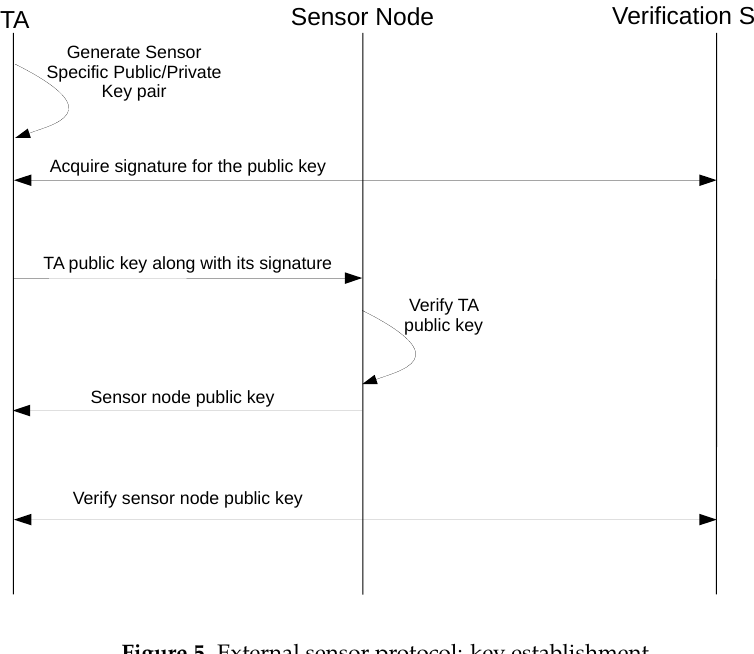
Figure 5. External sensor protocol: key establishment.